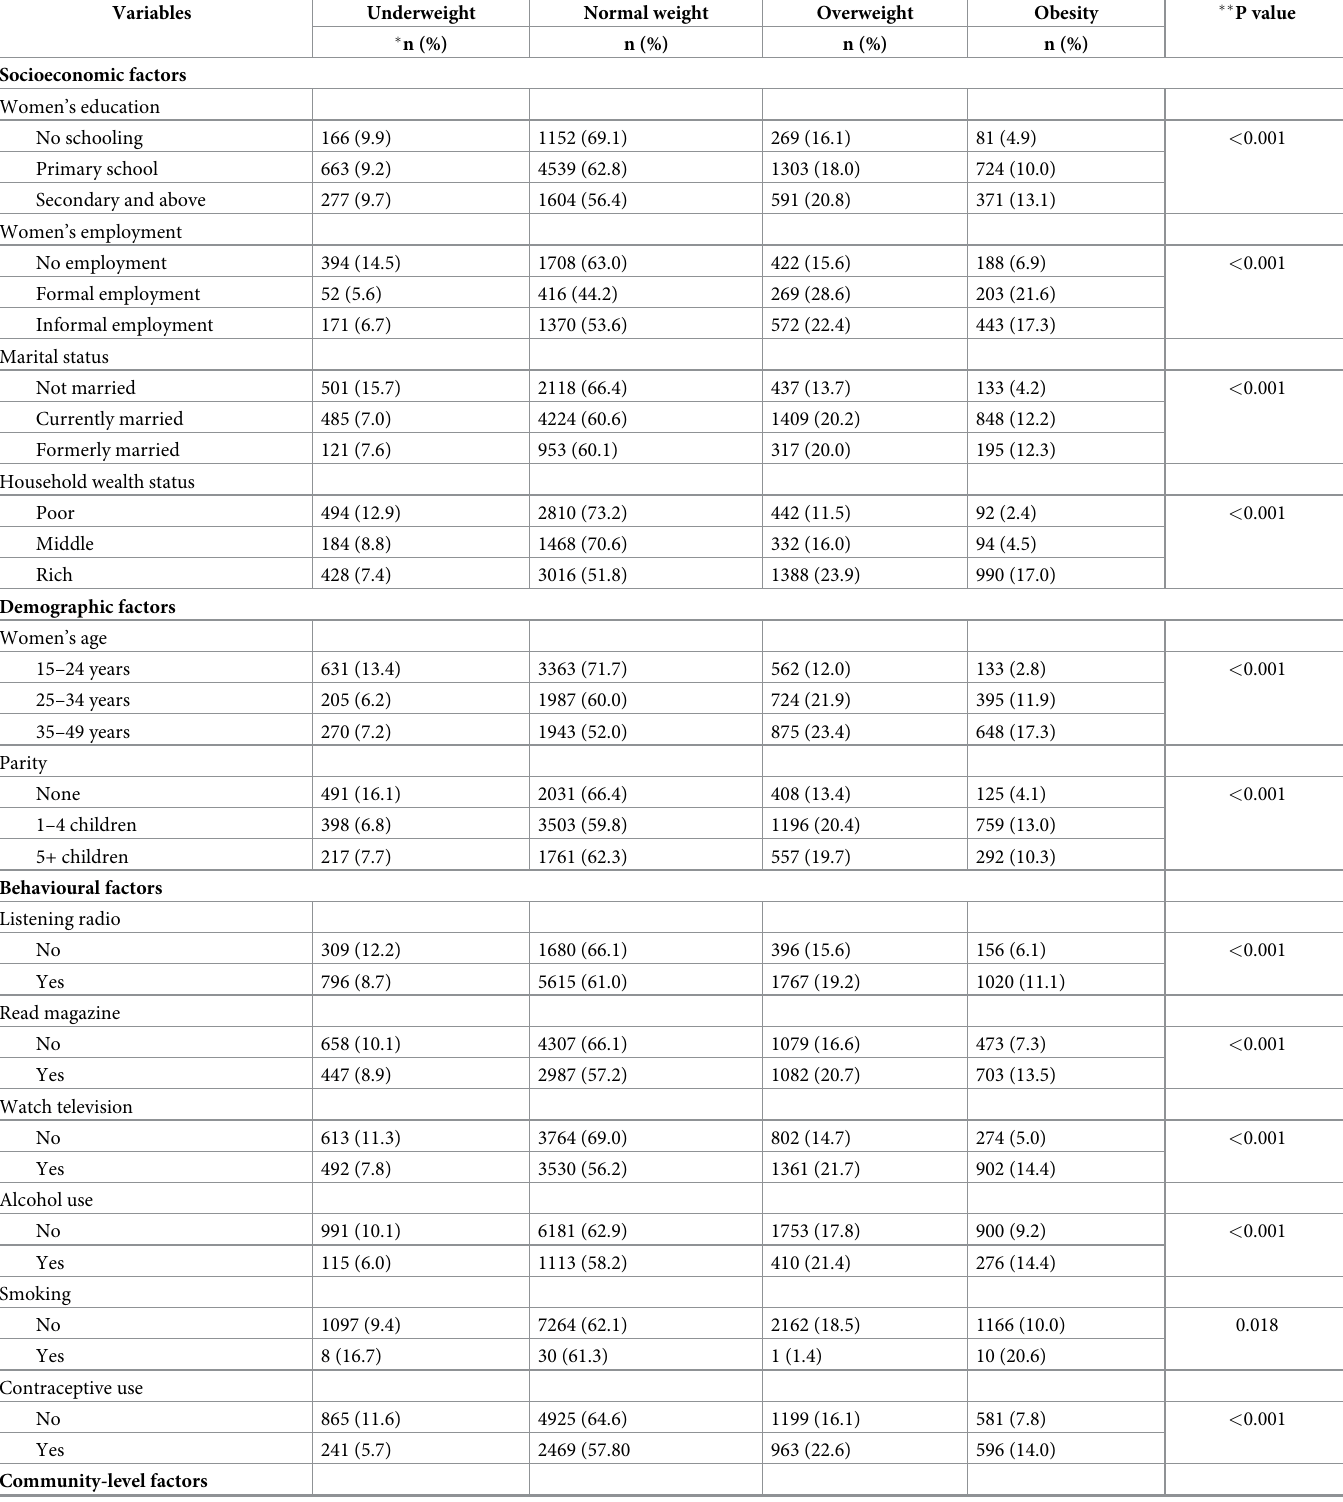
Table 1. Prevalence of underweight, overweight and obesity by study factors in reproductive age Tanzanian women, TDHS